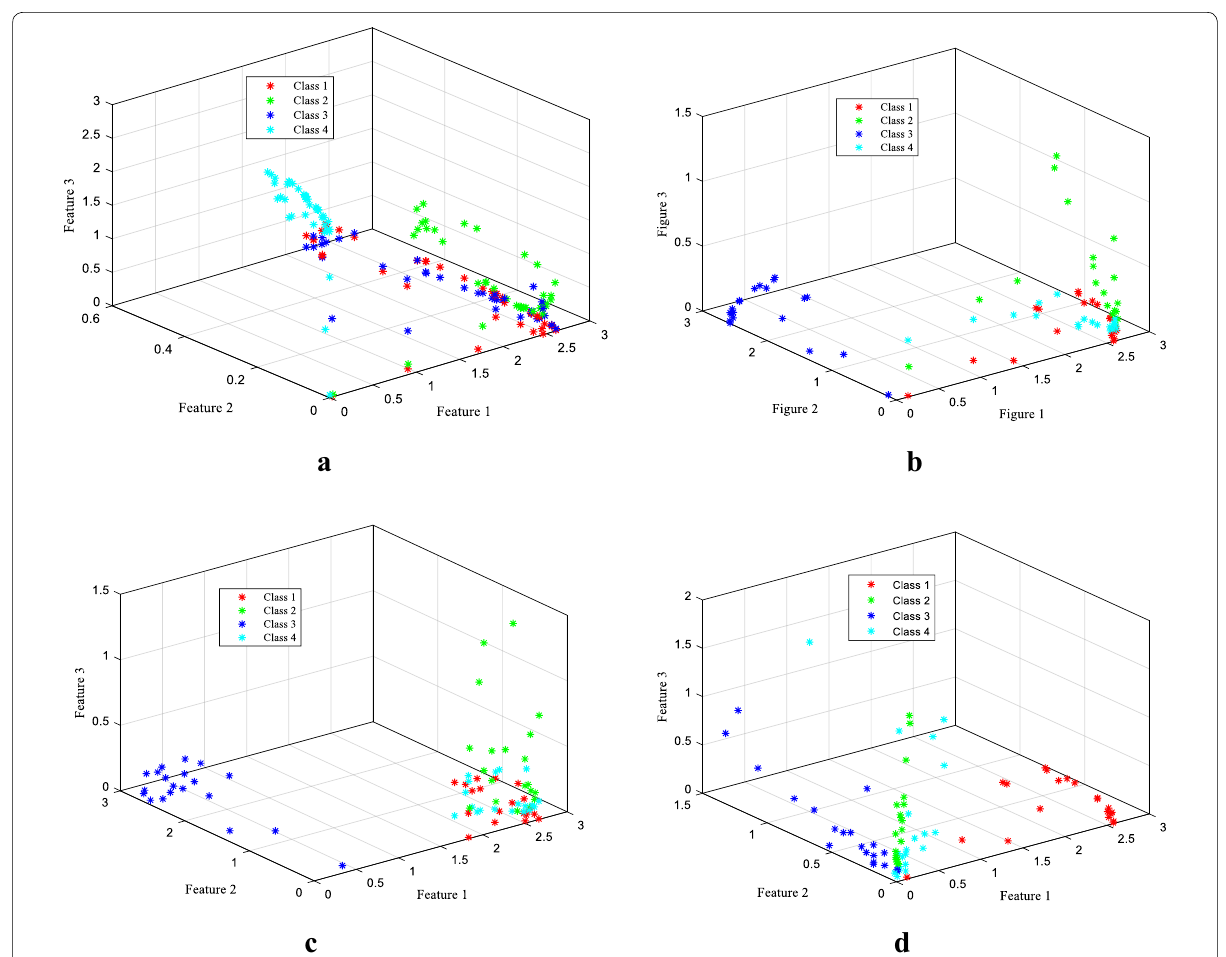
Fig. 6 Representation of the differentiability of the different methods among the features in feature space. a All WPT features, b selected features by Shannon theory, c selected features by mutual information theory, and d selected features by Rényi’s min-entropy algorithm